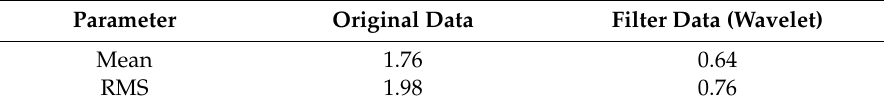
Table 2. INS position errors before and after wavelet de-noising of inertial data.